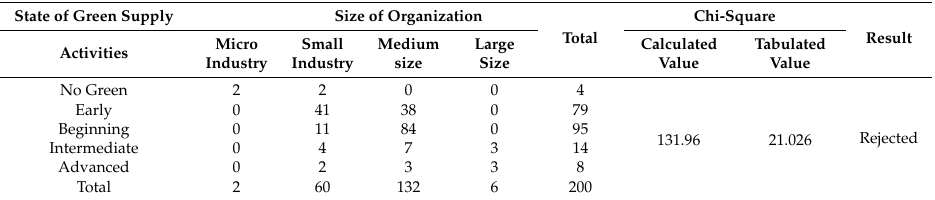
Table 6. Chi-square test results to measure the association between the state of the green supply chain management process and the size of an